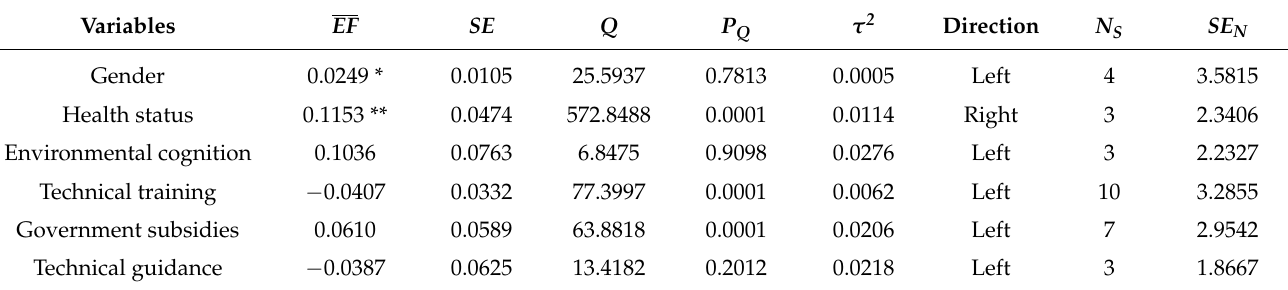
Table 3. Publication bias